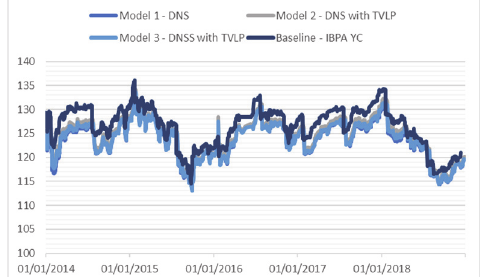
Fig. 10 . Fair price result comparison for FR0039 Fig. 11 . Fair price result comparison for FR0037